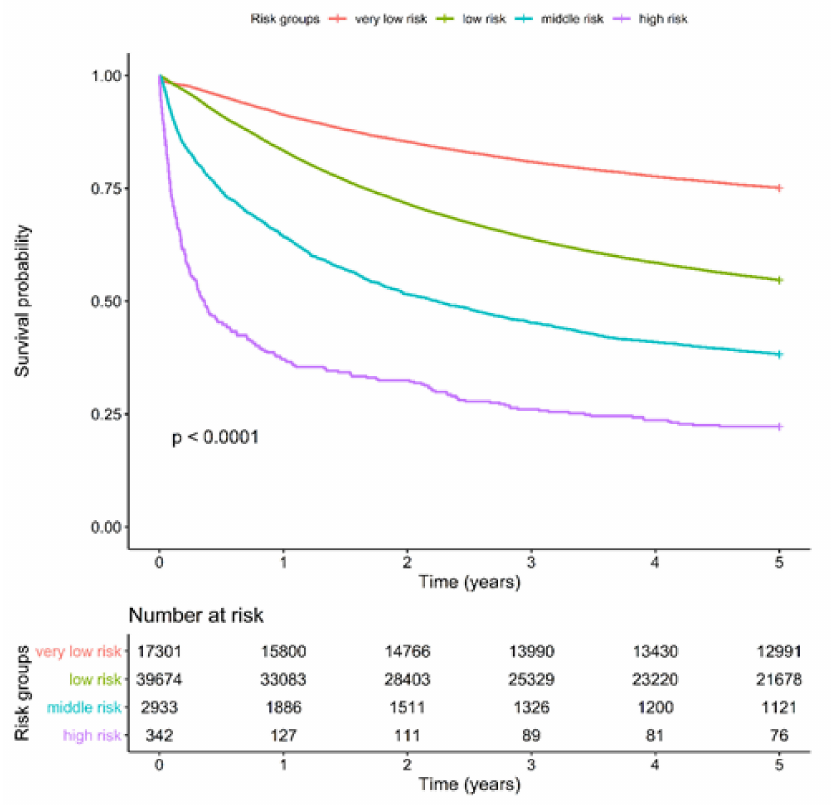
Figure 2. Kaplan–Meier 5-Year Survival Curve for Long-Term Mortality Rate of Four Chang Gung-PohAi-Major Hepatectomy Mortality Predictive Scoring System Groups. Note: p (log-rank test